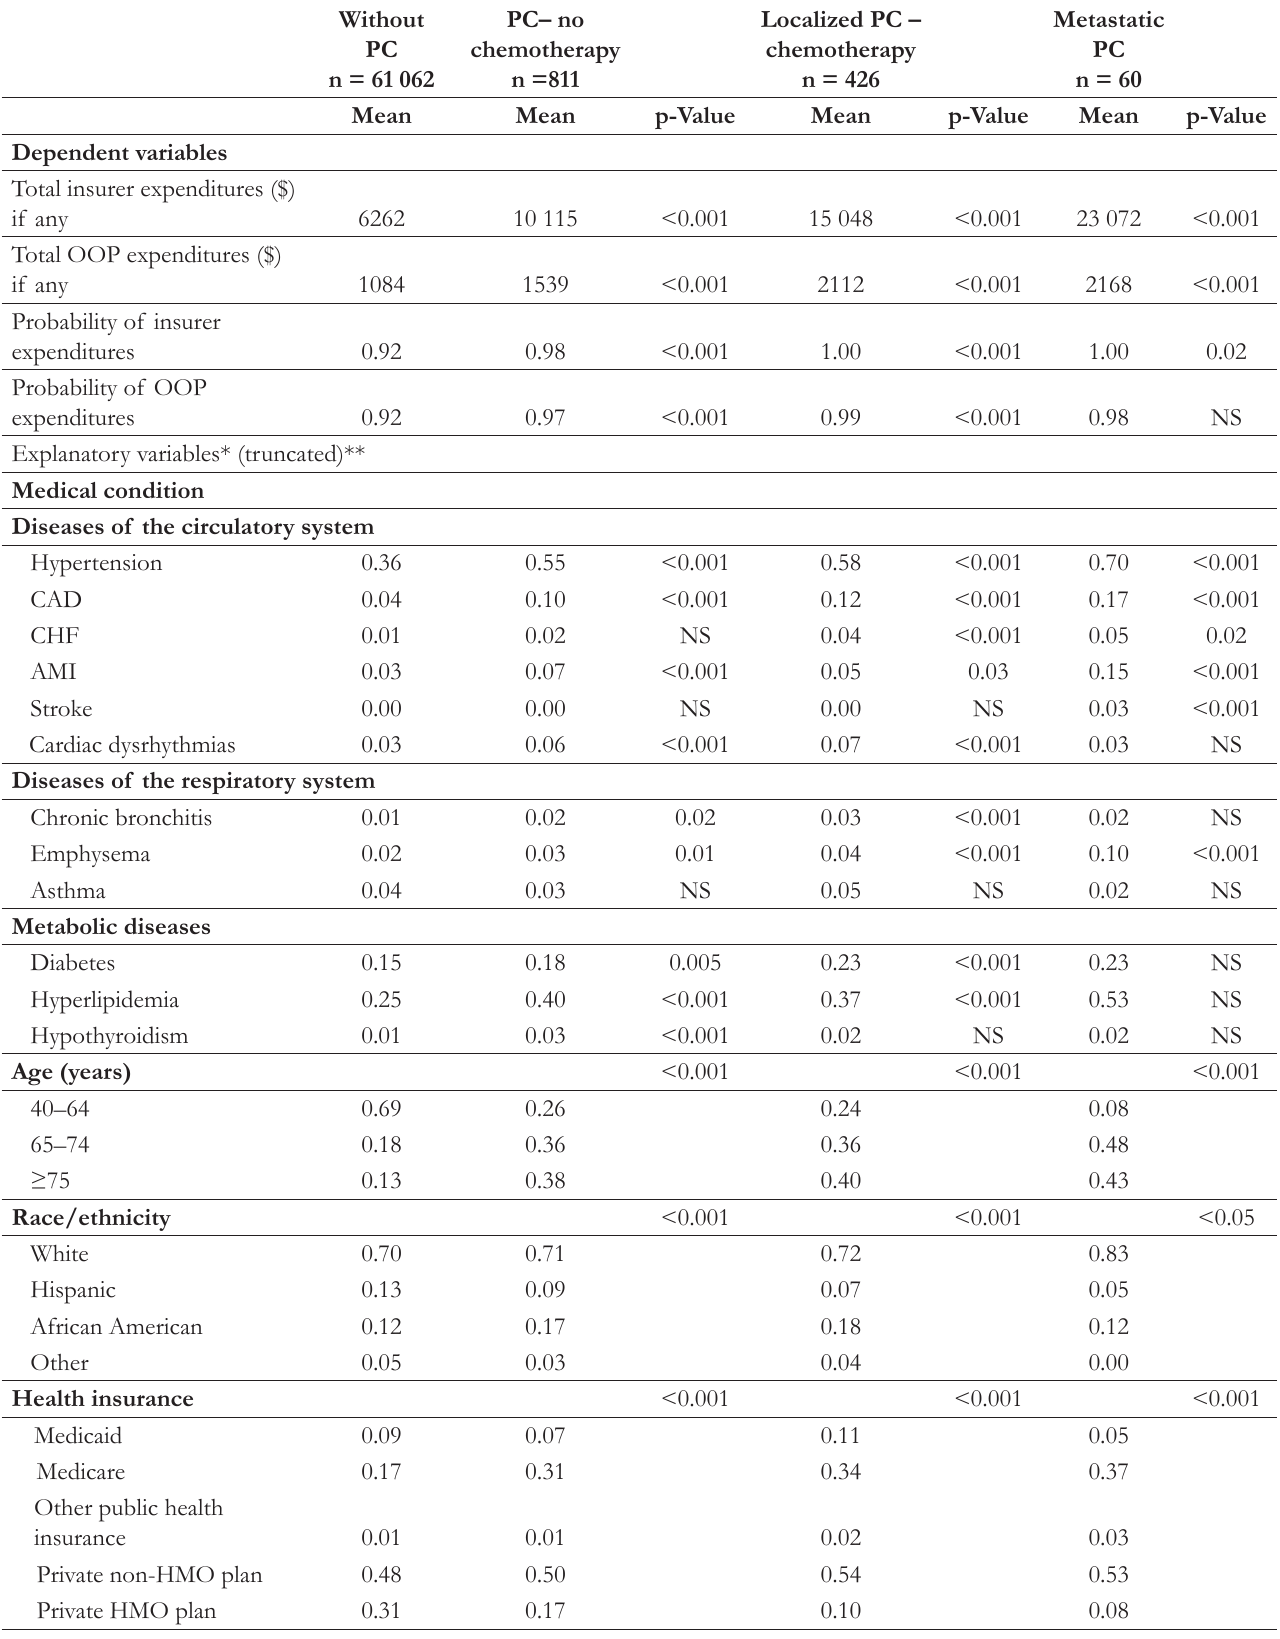
Table 1. Descriptive Statistics of Study Variables by PC Status for Direct